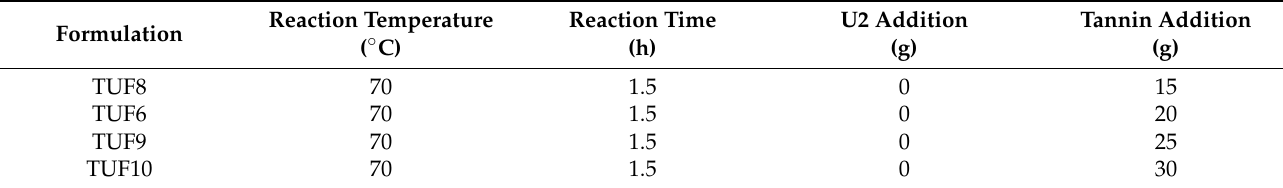
Table 3. Tannin content as a variable for the synthesis of TUF